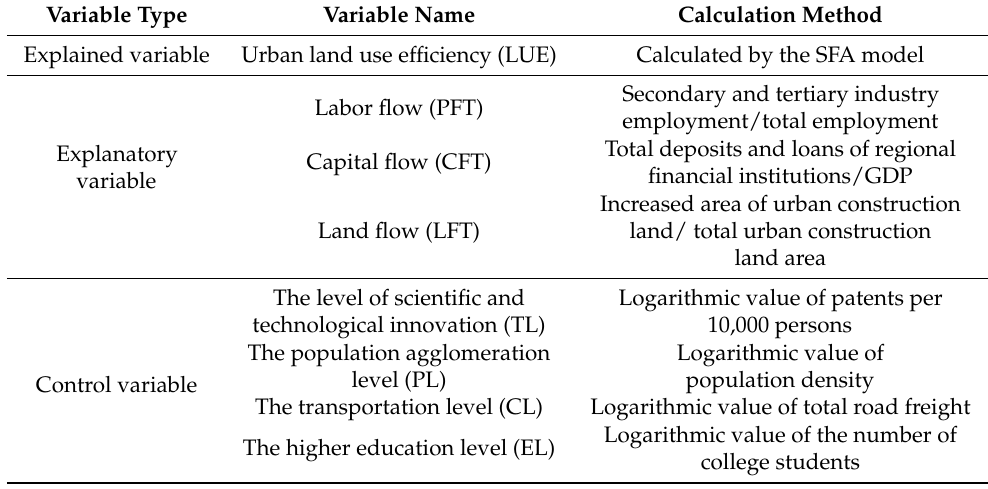
Table 2. Variable